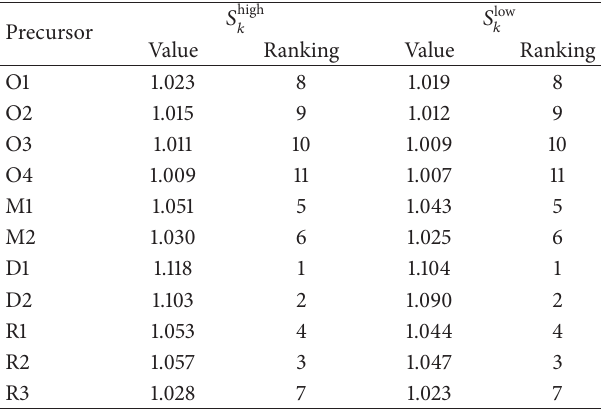
Table 10: Sensitivity of the goal with the change of prior probabili- ties.